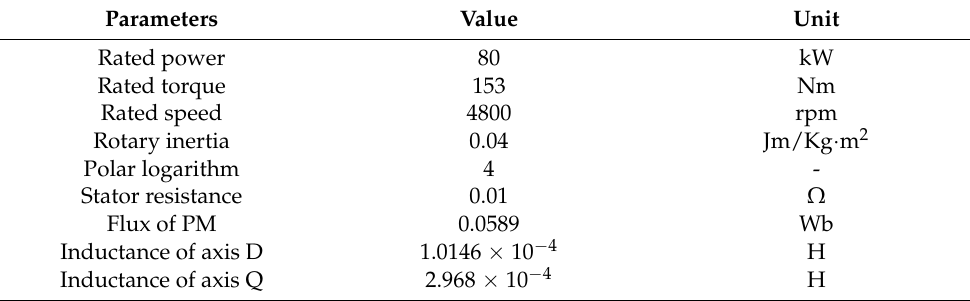
Table 2. Main parameters of the PMSM.